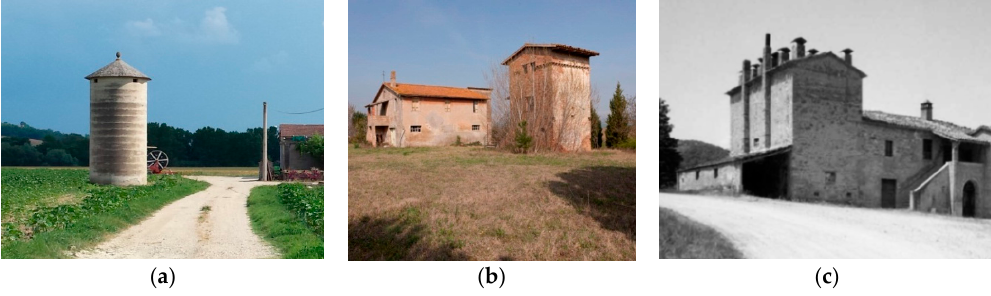
Figure 1. Rural buildings in central Italy, from the left: ( a ) a grain store silo; ( b ) a dovecotes tower; ( c ) a tobacco drying kiln.